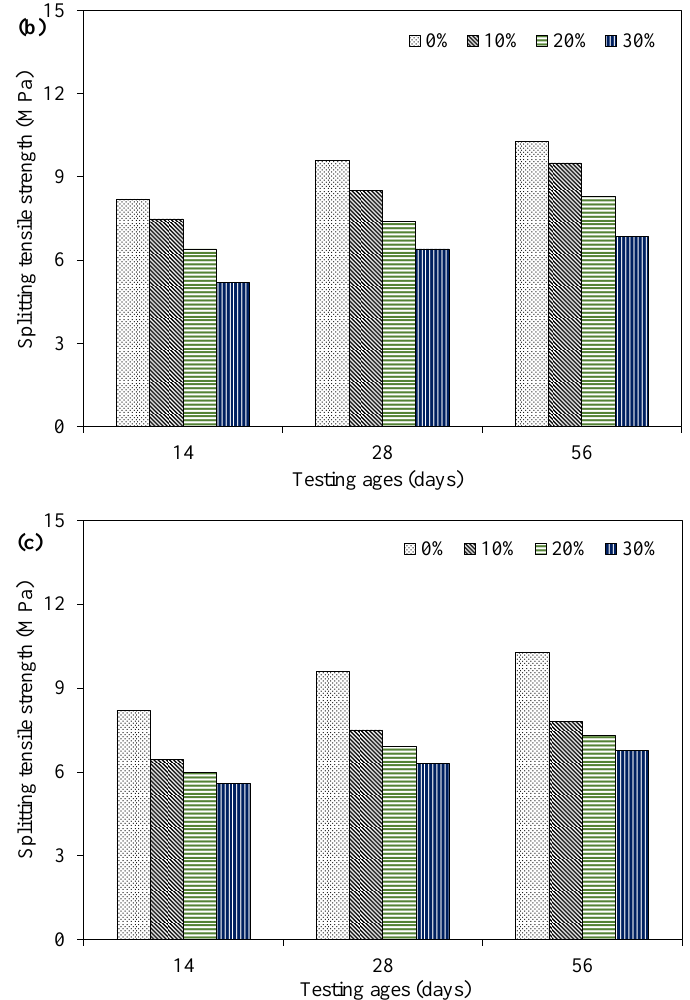
Figure 10. Splitting tensile strength results for specimens incorporating various dosages of rubber: ( a ) R1, ( b ) R5, ( c ) R10.